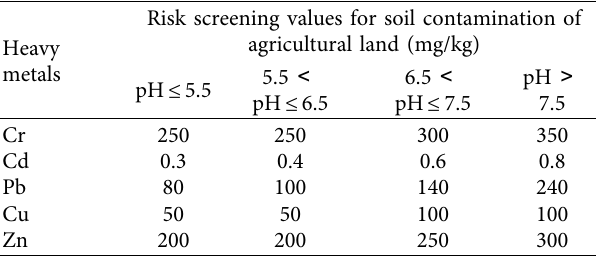
Table 2: Soil Environment Quality Risk Control Standard for Soil Contamination of Agricultural Land in China